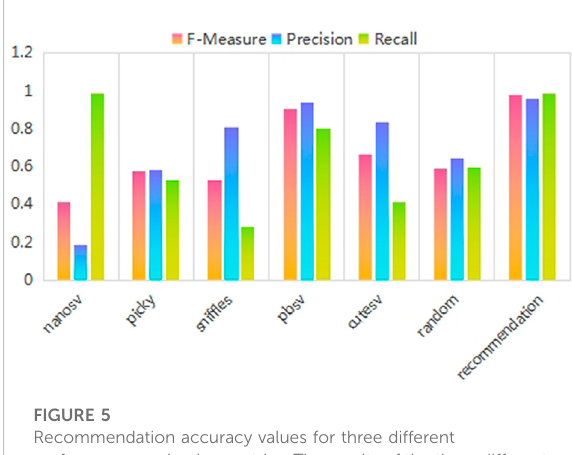
FIGURE 5 Recommendation accuracy values for three different performance evaluation metrics. The results of the three different performance evaluation metrics are displayed on three different colored bars. The abscissa indicates the fi ve fi xed SV callers, a randomly selected SV caller, and the recommended SV caller in order. The ordinate is the recommendation accuracy